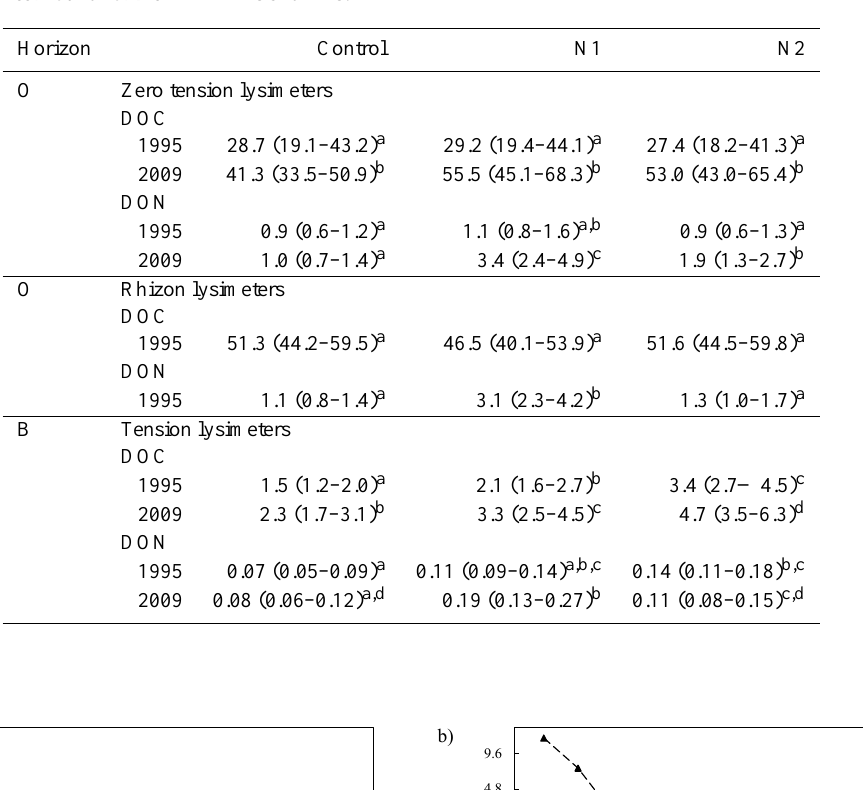
Table 4. Means (95% confidence intervals) of concentrations of dissolved organic carbon (DOC) and dissolved organic nitrogen (DON) in O and B horizon leachates in 1995 and 2009 at Str˚asan ( n = 24). Both DOC and DON are in mgL − 1 . Superscripts ( a , b , c and d ) denote significant differences at P = 0 . 05 (Tukey HSD). Within lysimeter type and variable, means lacking a common superscript differ. Significant interaction Treatment ∗ Year found for DON in ZTLs and TLs.